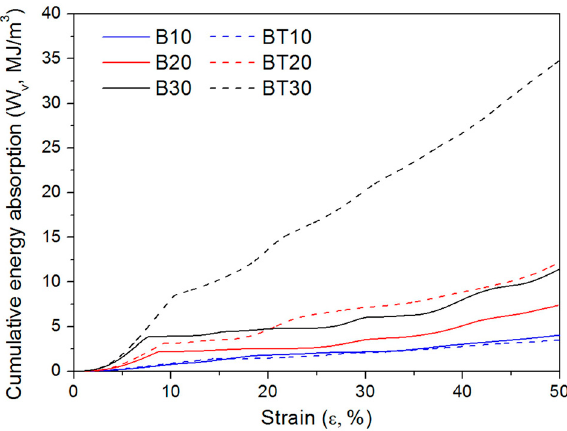
Figure 13. Curves between cumulative energy absorbing per unit volume ( W v ) and strain ( ε ) of CAD-based and TPMS-based samples under compression test.